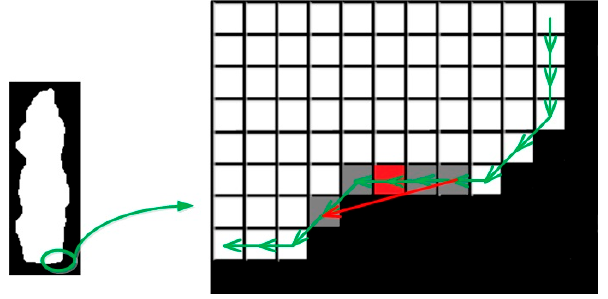
Figure 5. Computation of the contour point’s tangent vector based on four neighborhoods. For example, the tangent vector of the point in red is computed as the summation of vectors of its four neighborhoods in